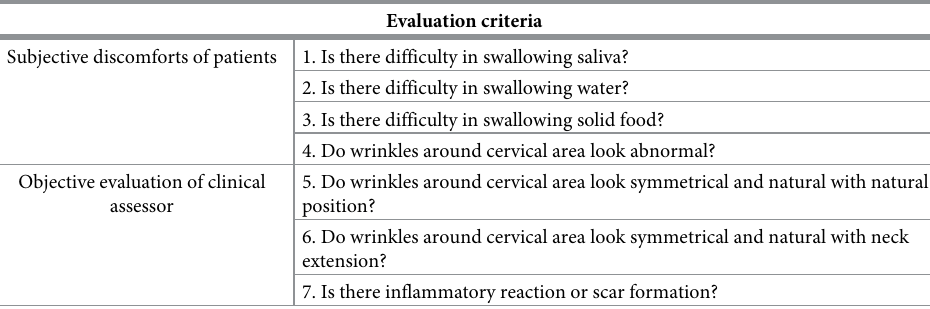
Table 2. Adhesion score